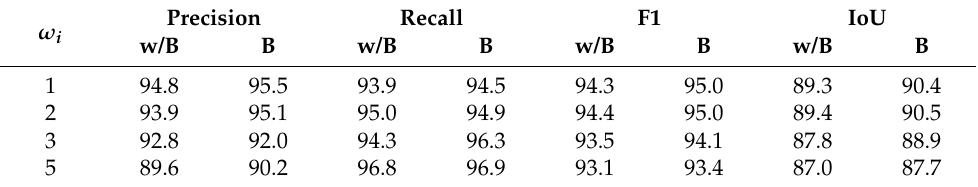
Table 3. The performance comparison (%) of networks with different architectures and loss functions on the WHU Aerial Building Dataset. “w/B” denotes networks that only learn building extraction, and “B” denotes networks that simultaneously learn building extraction and boundary detection. Precision Recall ω i